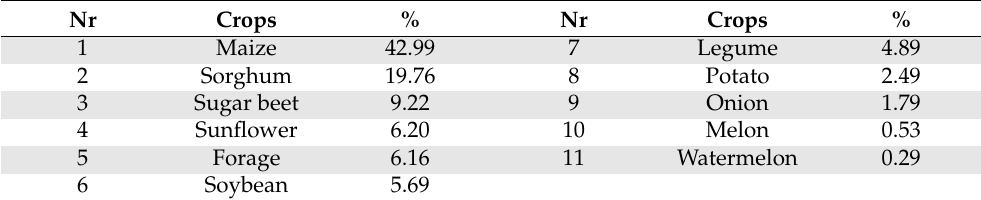
Table 3. Details of sample proportion of ‘other crops’ class. For all experiments, the proportion remains the same.